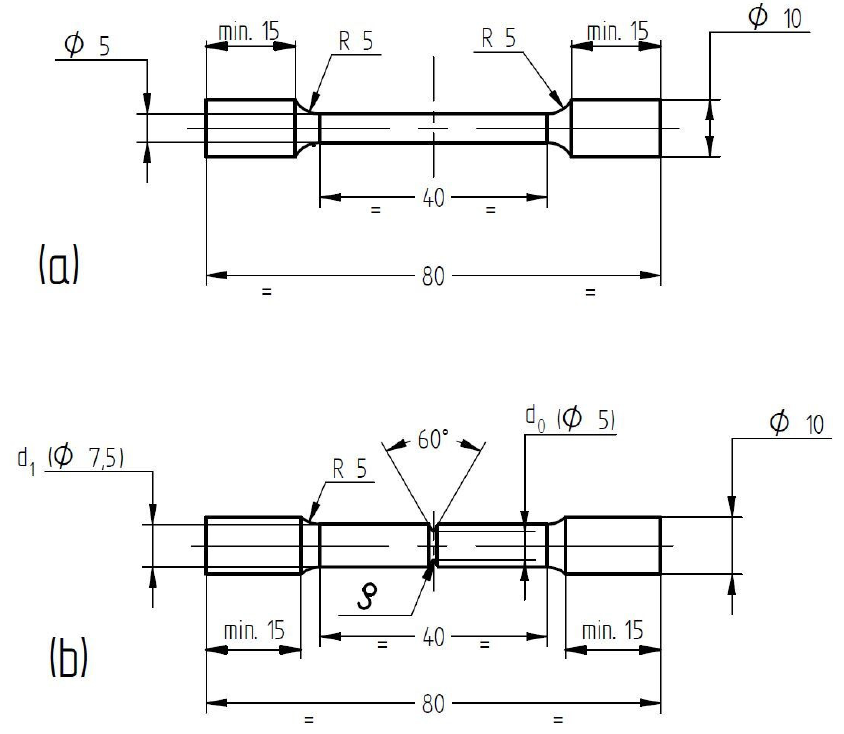
Figure 3. Tensile test pieces dimensions: smooth ( a ) and notched test pieces ( b ) (units in millimeters).